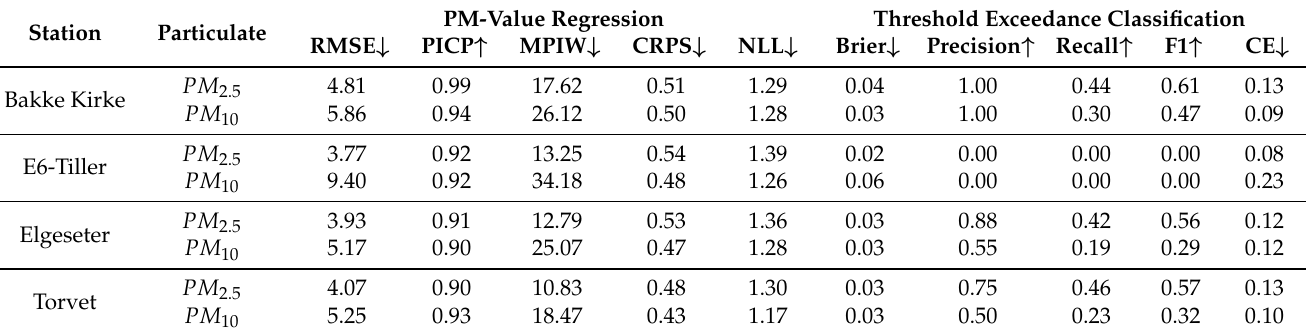
Table 2. Summary of performance results when forecasting the PM-value and threshold exceedance using a BNNs model.